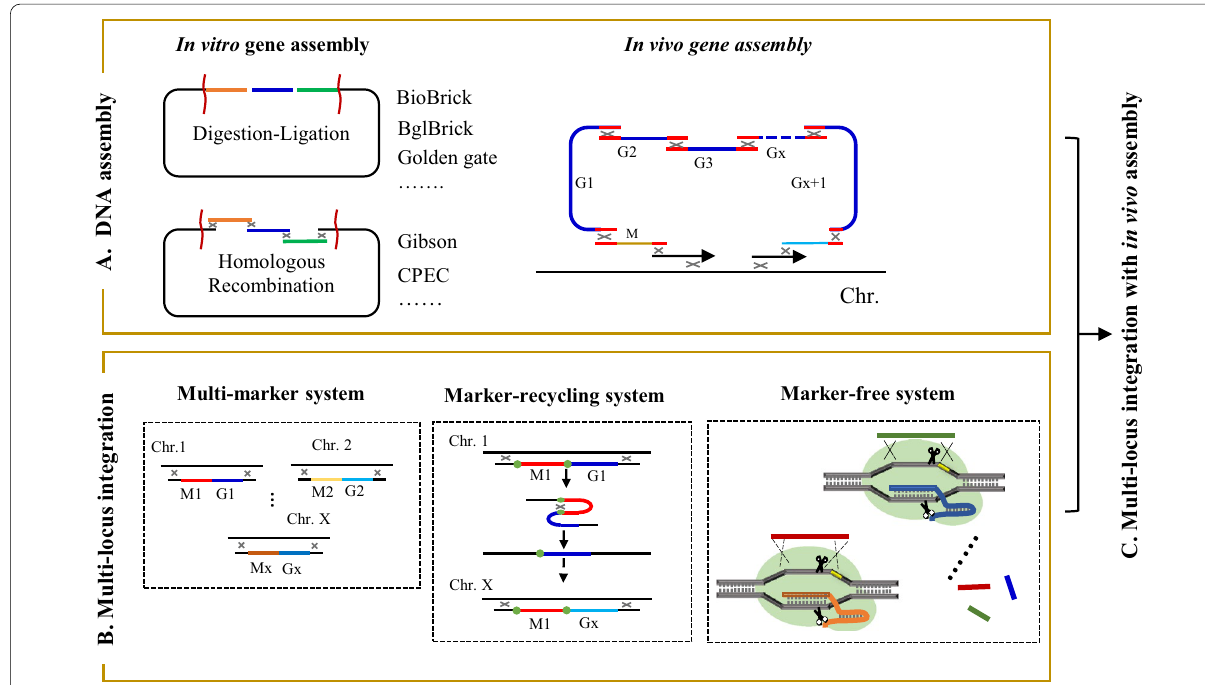
Fig. 3 Overview of innovative methods for pathway assembly. A Assembly of multiple genes into one large plasmid or one genomic locus. Restriction digestion/ligation-based methods with usage of type II and type IIs restriction enzymes are employed for in vitro gene assembly. Sequence homology-based methods are adopted to join multiple DNA fragments within one step in vivo or in vitro via short overlap. B Multi-locus integration of long pathway by splitting the whole pathway into several segments and then inserting them into multiple sites within one step or by multi-round integration, utilizing multiple markers, recycling markers or adopting marker-free systems. C Combination of multi-locus